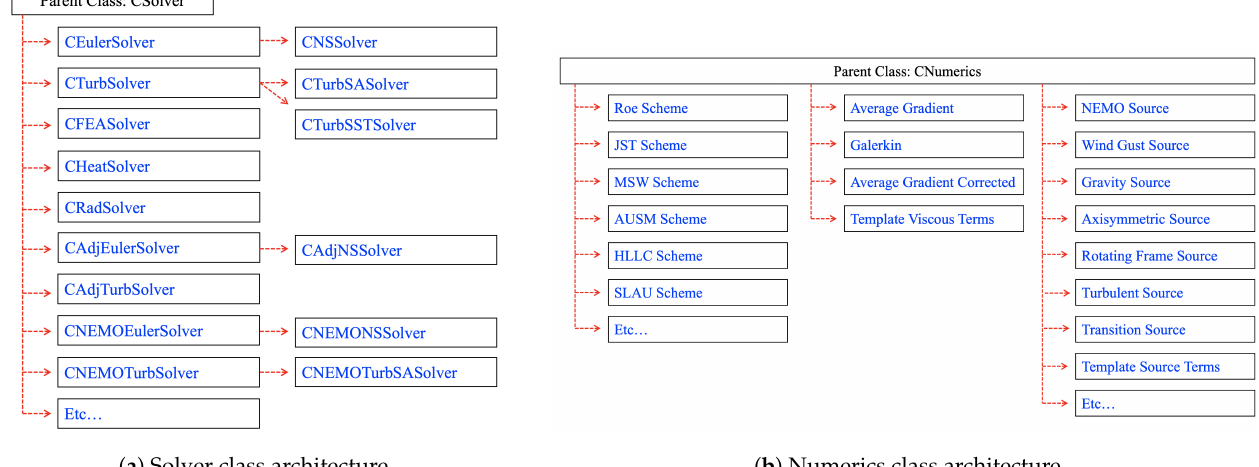
Figure 2. Diagrams of extensions of SU2 classes implemented in SU2-NEMO for simulating nonequilibrium